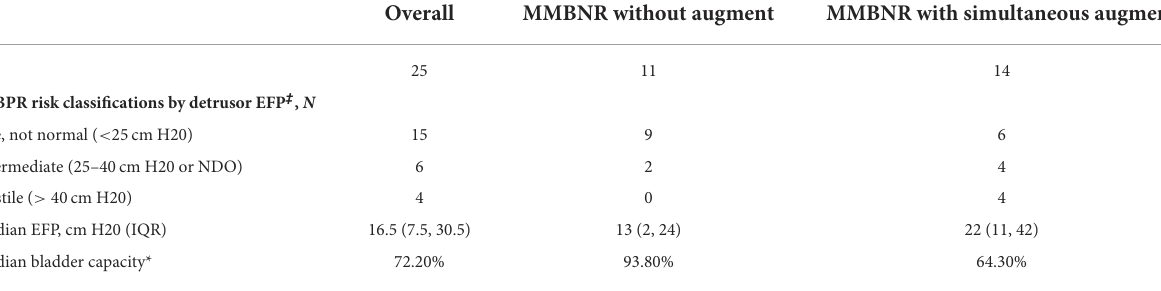
TABLE 2 Preoperative urodynamic characteristics stratified by MMBNR with simultaneous augment vs. no augment.